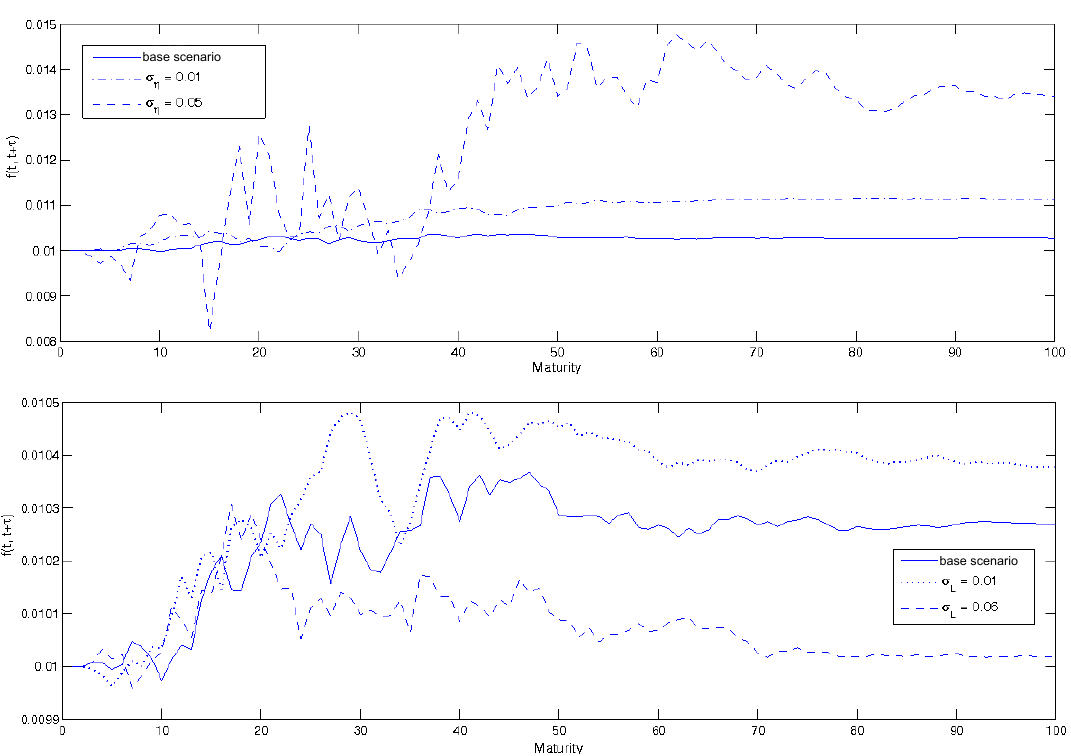
Figure 11. Forward instantaneous rate to varying volatility of ambiguity factor L .